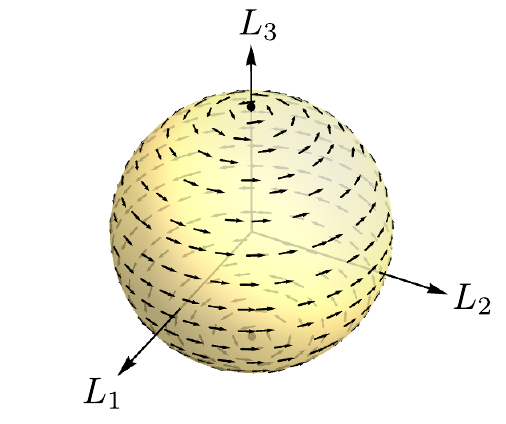
Figure 2 . A coadjoint orbit of SO(3) is a sphere. The irreducible unitary representations of SO(3) come from quantizing the spheres with integral surface area. The vector (cid:12)eld (cid:24) = @ (cid:30) has two zeros, the north and south poles of the sphere. The character, (cid:31) ( q ^ (cid:24) ), is given by the Atiyah-Bott formula in terms of data at the (cid:12)xed points. This can be regarded as a path integral on the orbit computed using the method of stationary